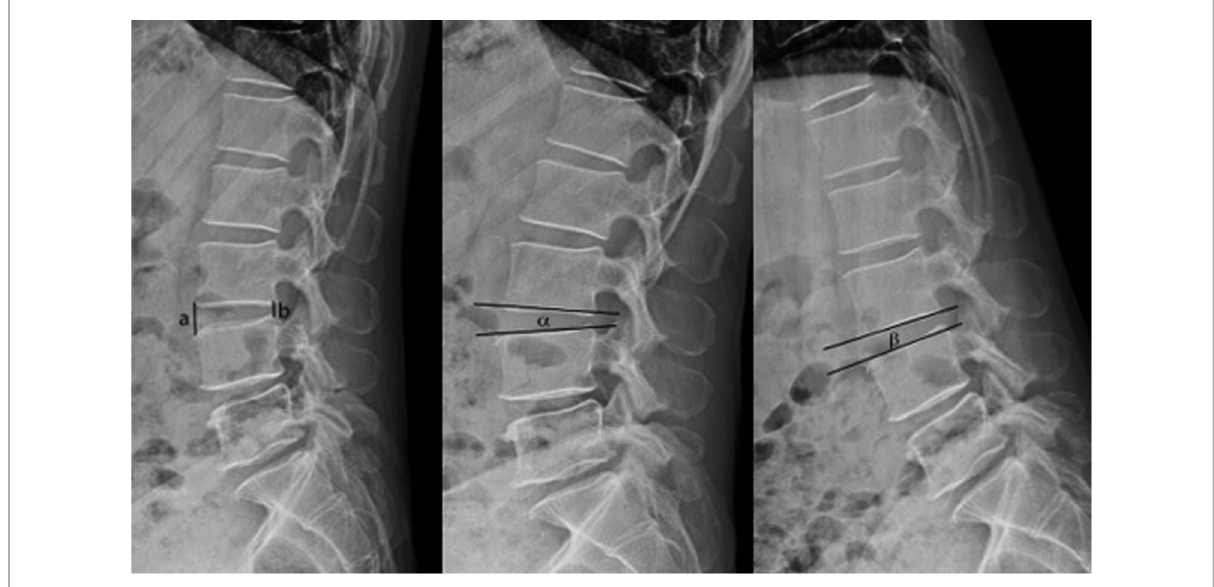
FIGURE 1 Dh and ROM: DH measurement method: the average value of the sum of the lines of the anterior and posterior edge of the upper and lower vertebral body, DH=(a+b)/2. ROM measurement method: the difference between the angle of intervertebral space in hyperextended position and fl exion position, ROM= α - β